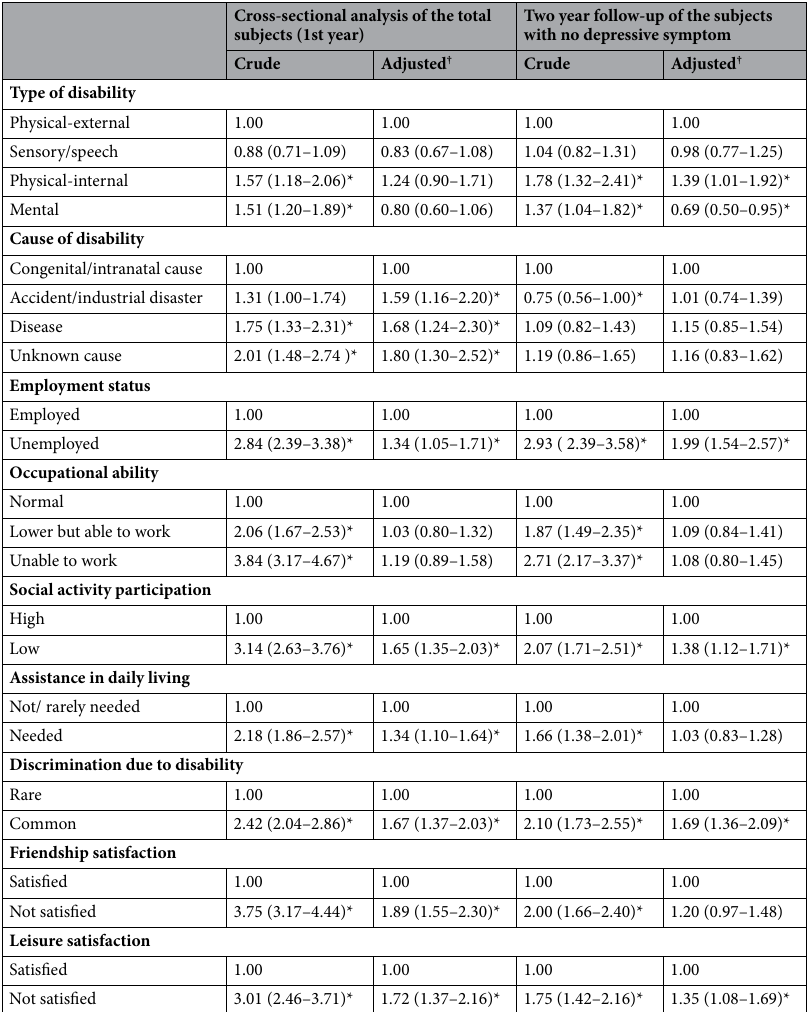
Table 2. A cross-sectional (at baseline of total participants) and a longitudinal (two-year follow up of participants without depressive symptom) analysis on the crude and adjusted hazard ratios (95% CI) for depressive symptoms. † Adjusted for type of disability, cause of disability, gender, age, marital status, household income, household size, area of residence, employment status, occupational ability, social activity participation, assistance in daily living, discrimination due to disability, friendship satisfaction, leisure satisfaction, chronic conditions, and smoking. During each stratification analysis, factors that were stratified for were not included in the